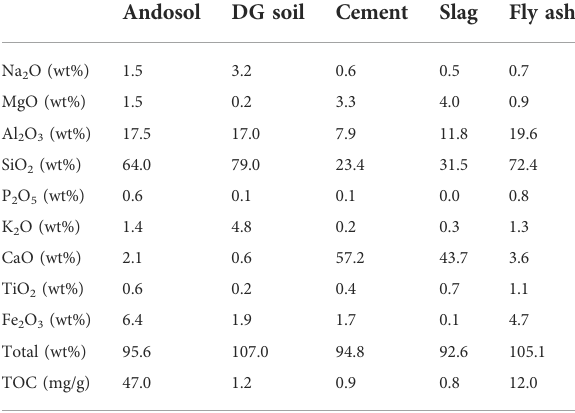
TABLE 1 Major element concentrations and total organic carbon (TOC) in the andosol, decomposed granite (DG) soil, Portland cement, steelmaking slag, and coal fl y ash samples used in this study.